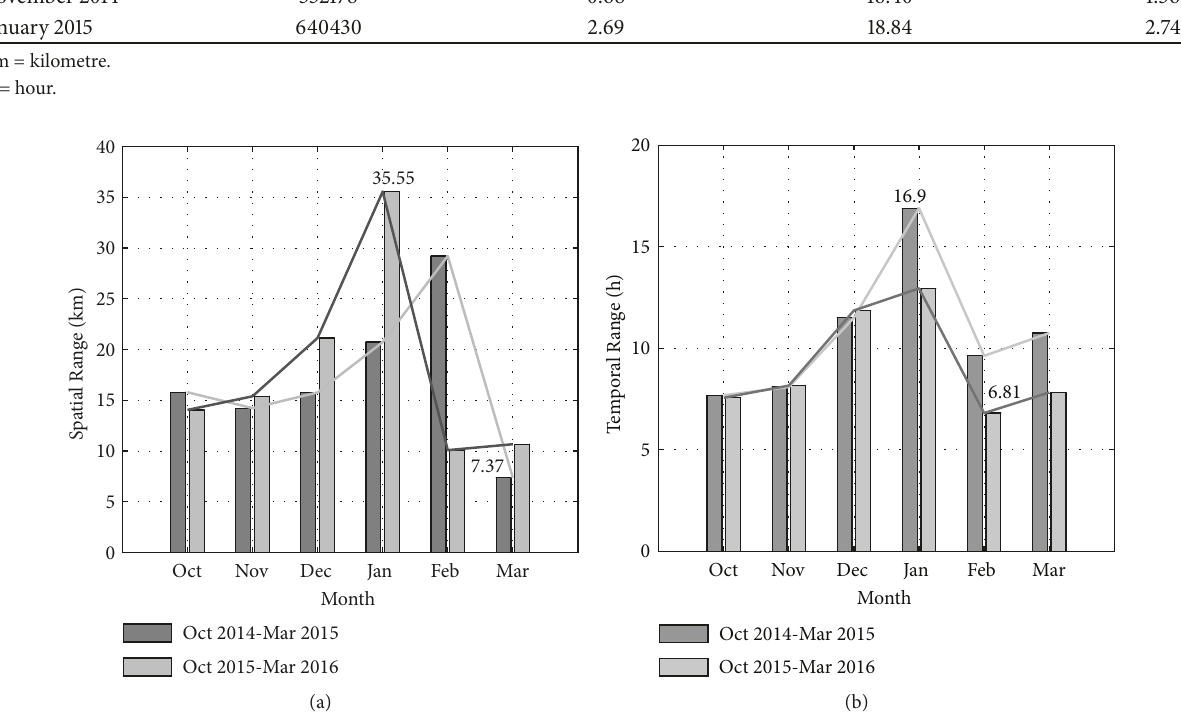
Figure 7: Monthly range variations from spatiotemporal variogram. (a) Spatial. (b)